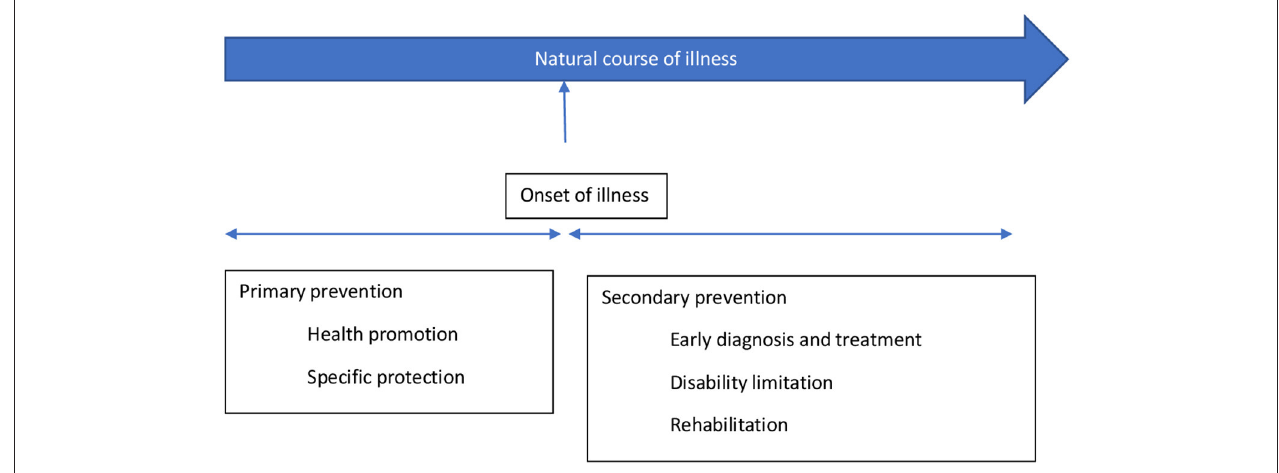
FIGURE 1 | The concept of primary and secondary prevention [adopted from prevention: Primary, Secondary, Tertiary by Bauman et al. (51)].